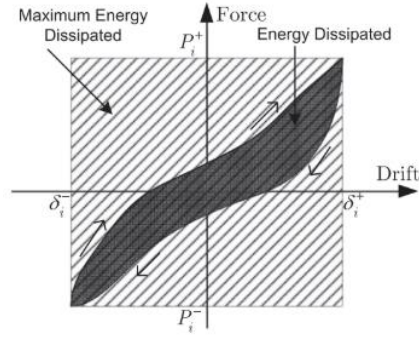
Figure 13. Definition of energy dissipation.